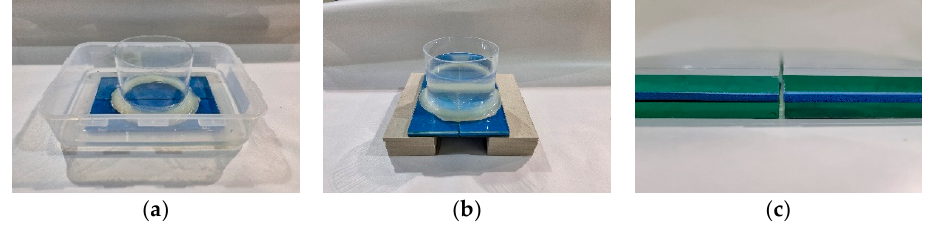
Figure 9. The leakage test method and status: ( a ) Immersion in water for 24 h; ( b ) Filling with distilled water; ( c ) Leakage detection.